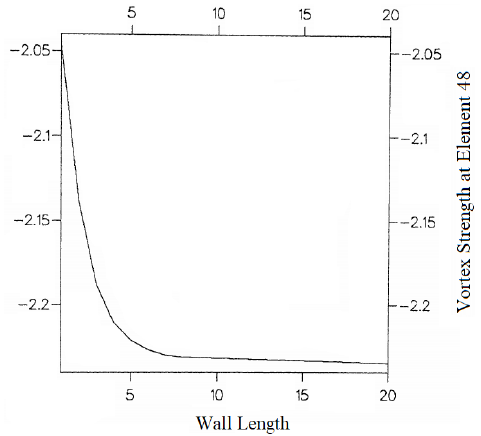
Figure 2. Effect of wall length to the cylinder.